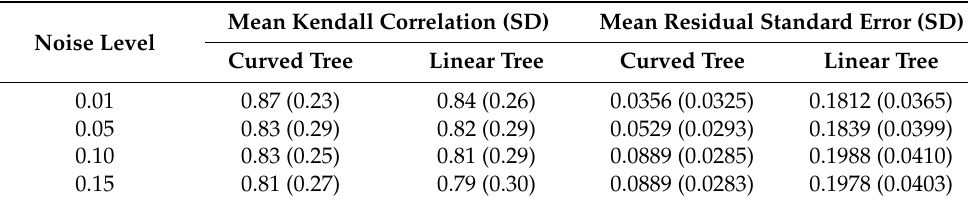
Table 1. Mean Kendall correlations and mean residual standard error for both curved tree algorithm and linear tree algorithm with different noise level.